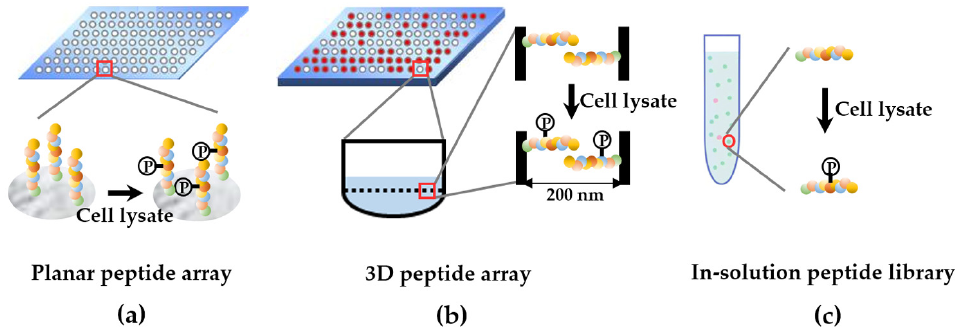
Figure 2. Overview of kinome profiling approaches based on the substrate peptide library.